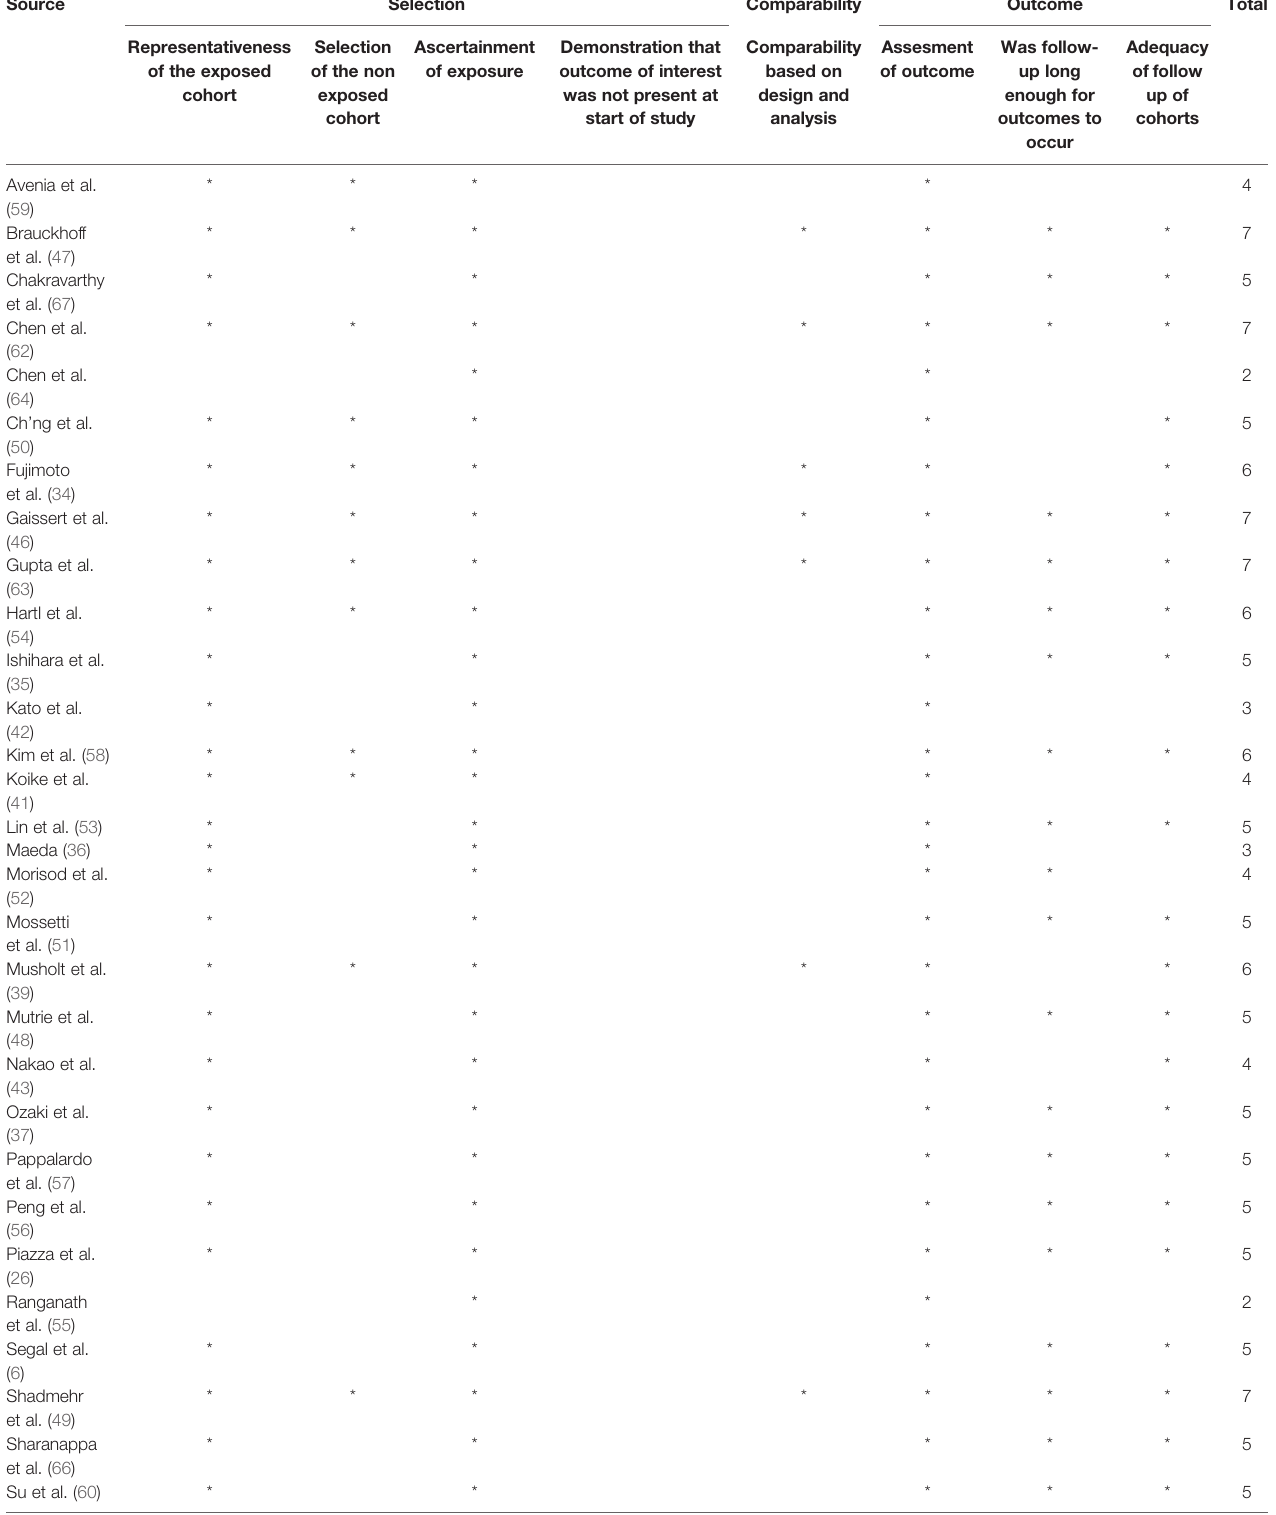
TABLE 3 | Quality assessment of papers included in the present systematic review